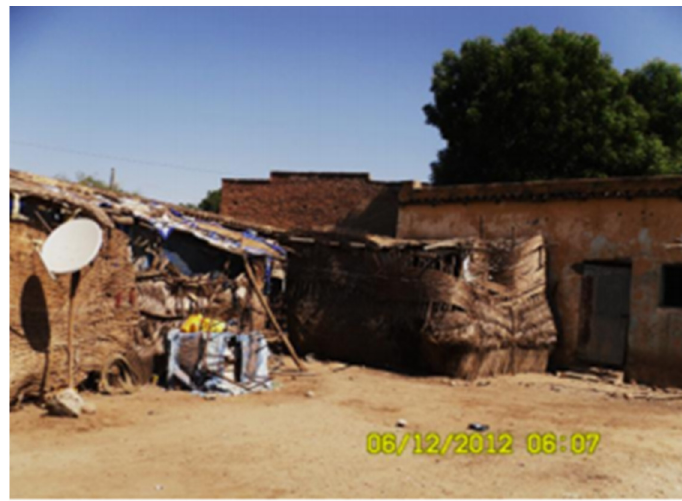
Figure 12. Backyard basket shelters .